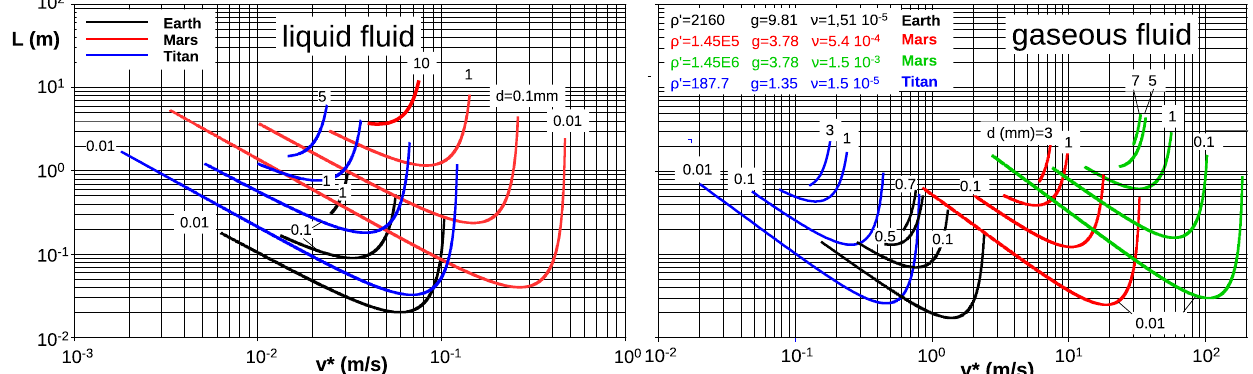
Figure 17. Examples of predicted ripple lengths on Earth, Mars, and Titan based on the theory presented here, noncohesive sediment assumed. (In case of gaseous fluids τ (cid:63) c here taken as τ (cid:63) data according to Lapotre et al., 2016 [44] assumed with ρ = 0.02 kg/m 3 , green: ρ = 0.002 kg/m 3 . Note: Real winds on Mars have been found to reach v (cid:63) < 4